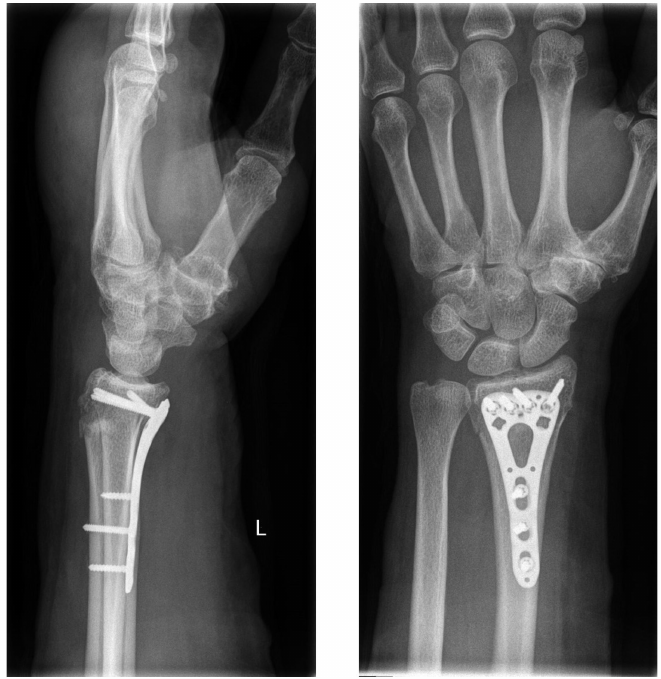
Figure 2. Standard operative treatment with palmar plate. Postoperatively, immobilization was carried out with a dorsal plaster splint versus the OPTIVOhand orthosis for 2 weeks, with mobilization of the adjacent joints. The used orthosis consists of a flexible polyester textile fabric with flexible adjustable Velcro fasteners and is reinforced by aluminum splints. It weighs 600–800 g. It is washable and can be used with an interchangeable splint for either the left or right wrist. The two available sizes were selected depending on the circumference of the patient’s wrist. In both plaster casting and orthotic therapy, a thin layer of cotton wool padding was applied to avoid pressure points caused by swelling (Figure 3A–E).